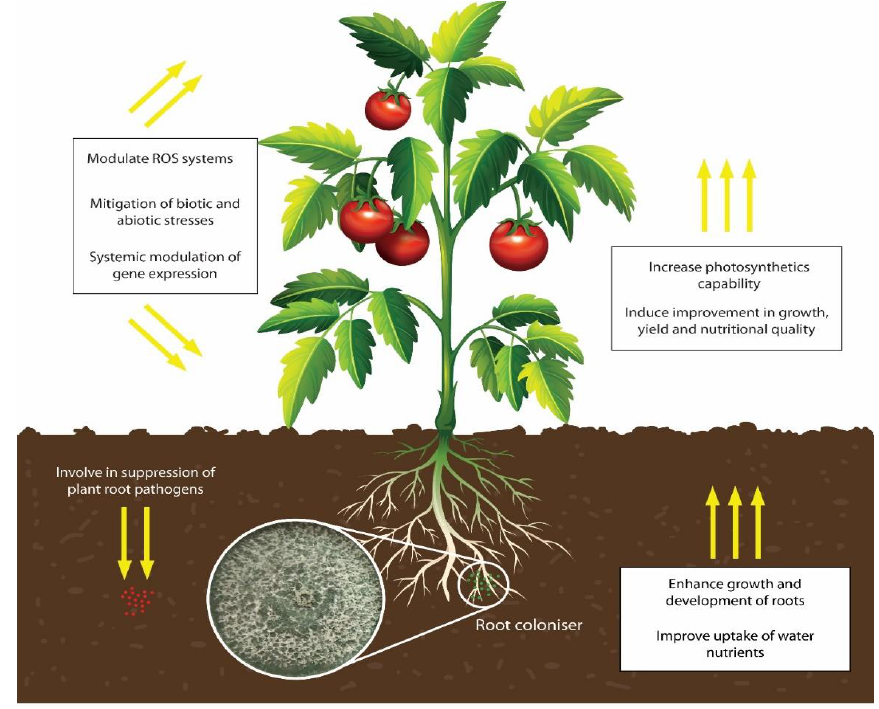
Figure 1. The effects of Trichoderma on plant growth, development and health.